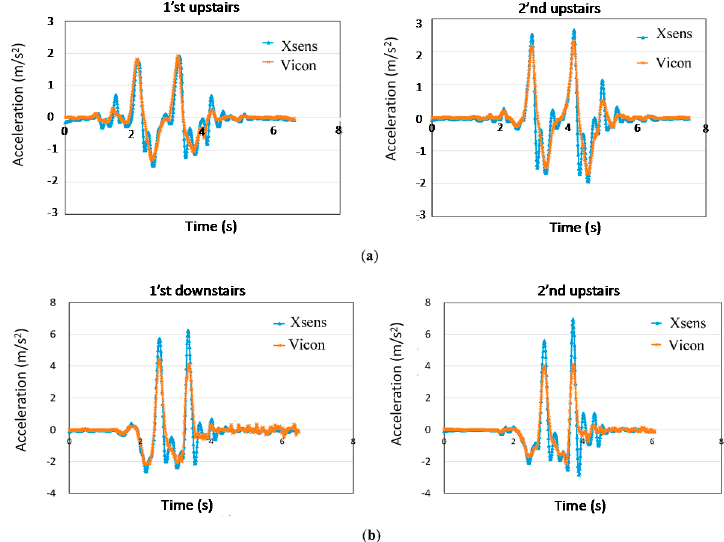
Figure 6. Validation of the Xsens accelerations ( a ) upstairs; and ( b ) downstairs with Vicon data.